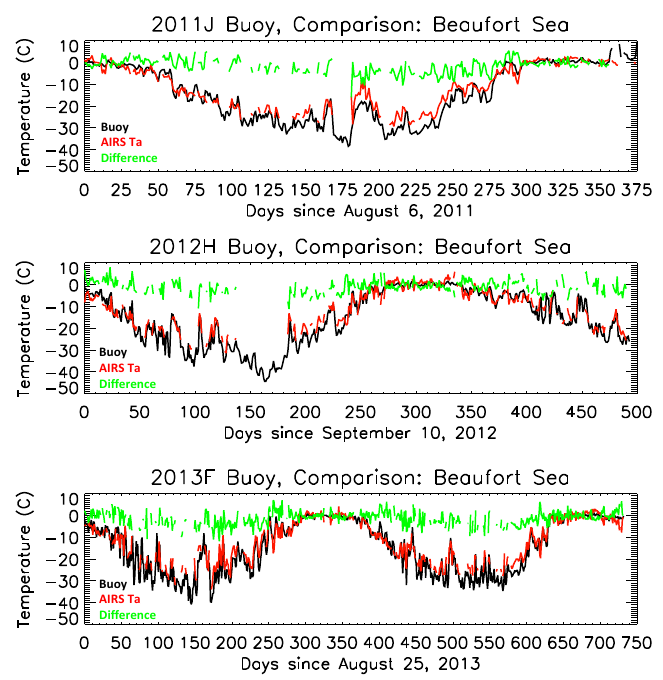
Figure 3. Time series for three buoys showing comparisons between in situ and AIRS-derived 2-m air temperatures. AIRS is shown in red, buoys in black and their difference (buoy-AIRS) in green. Spatial and temporal limitations still arise. Satellite data are only available once or twice daily